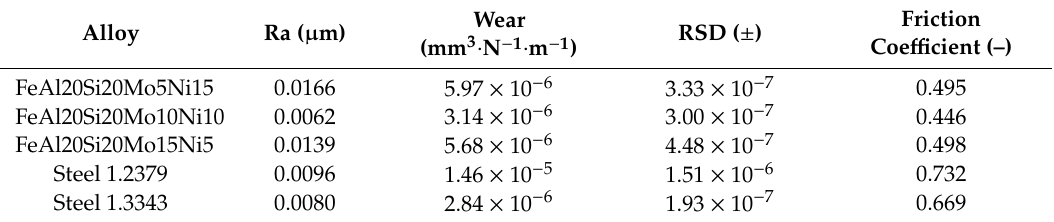
Table 5. Results of the wear tests done at laboratory temperatures of all the MA + SPS alloys and two references (Ra – surface roughness)